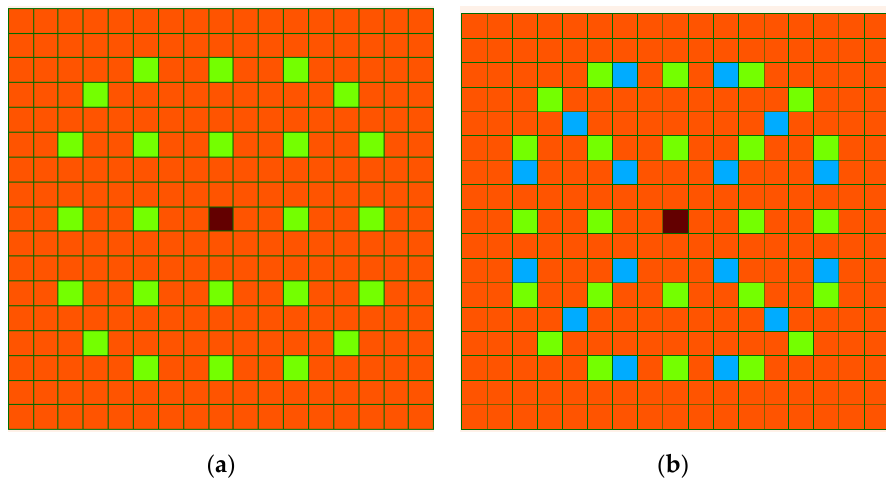
Figure 7. PWR and VVER Cell cases. ( a ) PWR UOX or MOX Cell. Fuel: UOX or MOX; ( b ) hexagonal UOX Cell. Fuel: UOX.